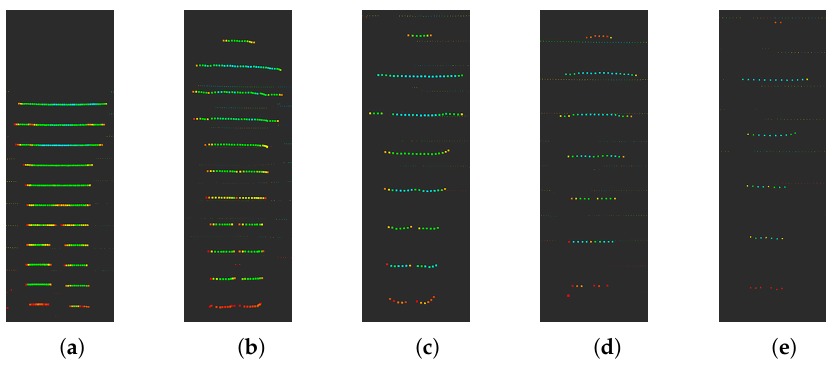
Figure 3. Sensed human body at different distances from a 3D LiDAR (Velodyne VLP-16) located at a height of 40 cm above the floor. The person is positioned ( a ) 2 m, ( b ) 4 m, ( c ) 6 m, ( d ) 8 m, and ( e ) 12 m from the